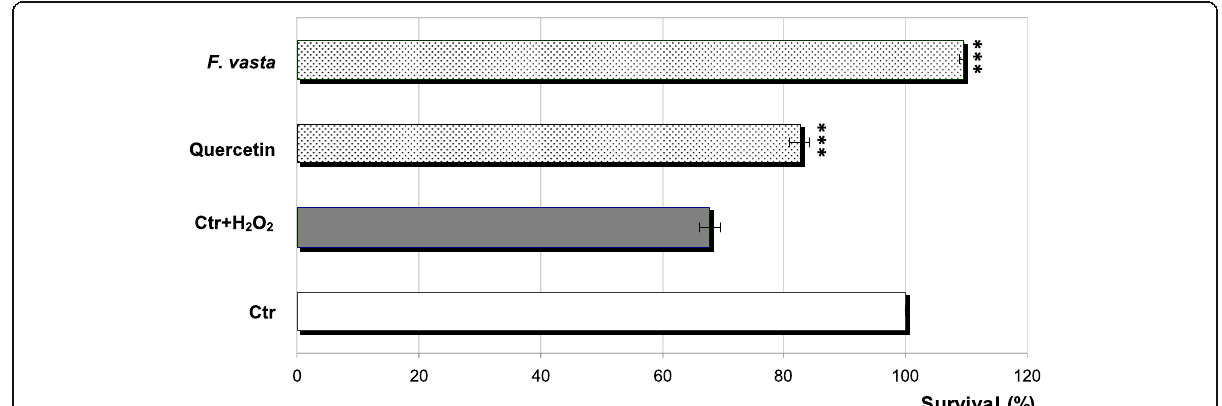
Fig. 4 Protective effect of F. vasta leaves hydroalcoholic extract on Escherichia coli survival under peroxide stress. Values are expressed as the mean ± SD (n = 3). Statistical differences compared to control group with H 2 O 2 treatment (Ctr + H 2 O 2 ) are noted with asterisk (***P <